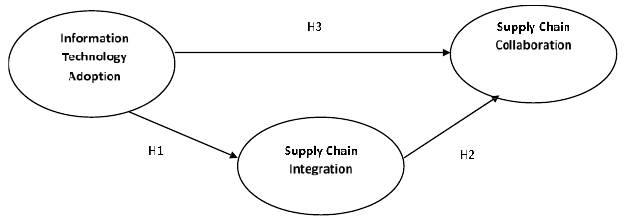
Figure 1: A conceptual research